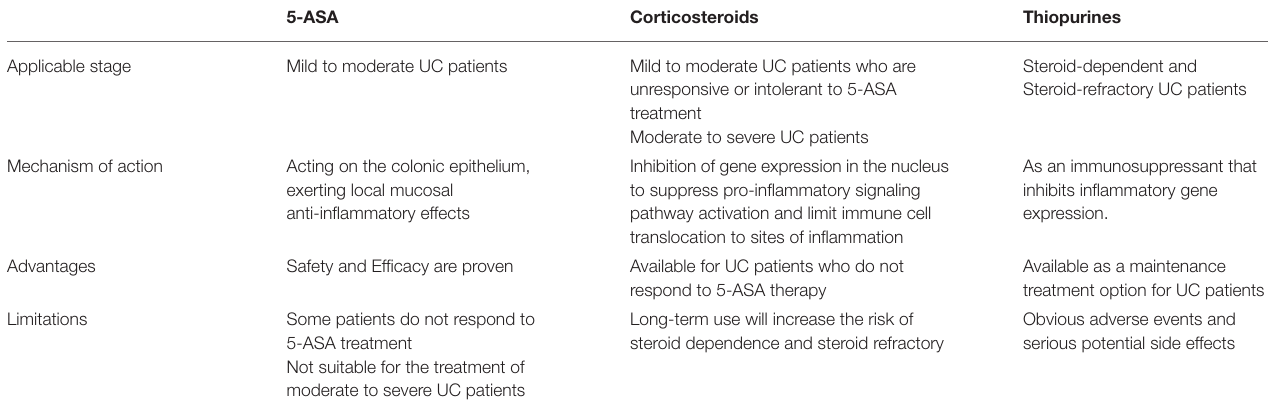
TABLE 1 | The difference of three types of commonly used drugs in treating